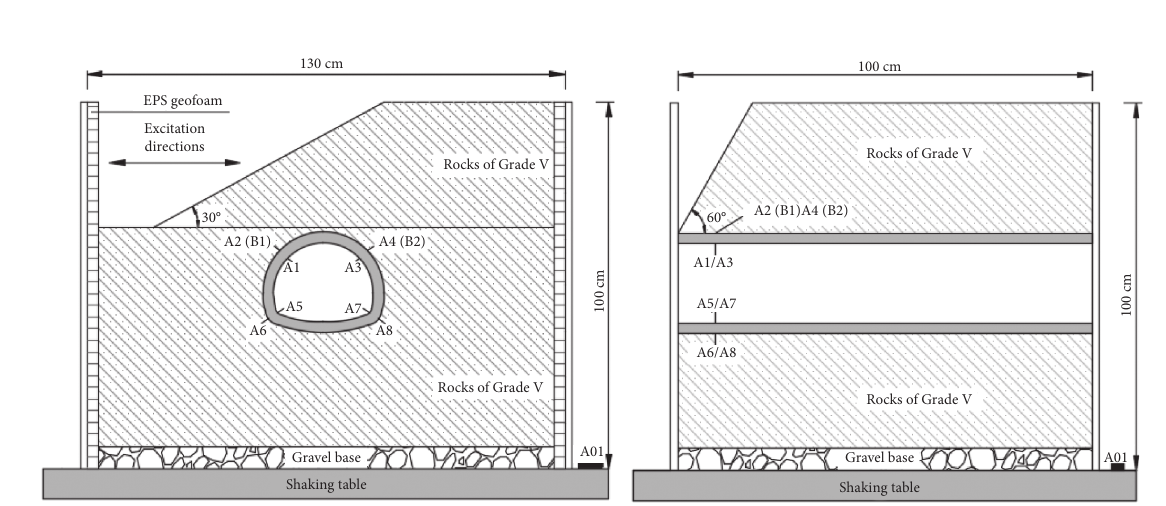
Figure 6: Surrounding rock and layout of transducers (B/C), strain gauges; (A), accelerometer).